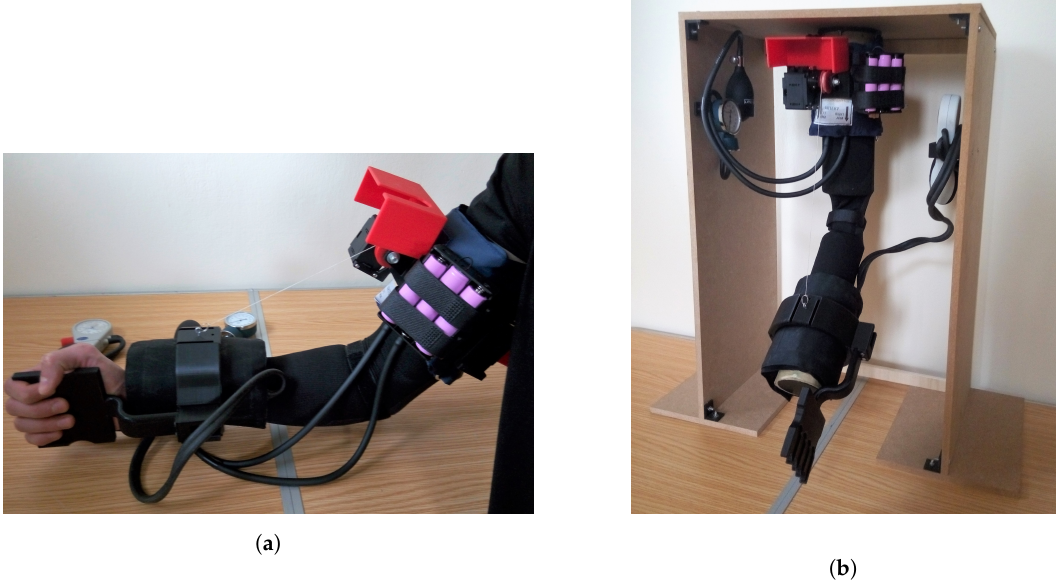
Figure 10. The CADEL.3 prototype at Lab of Robotics in Padova as in Figure 9: ( a ) worn by a healthy person; ( b ) installed on a testbed.